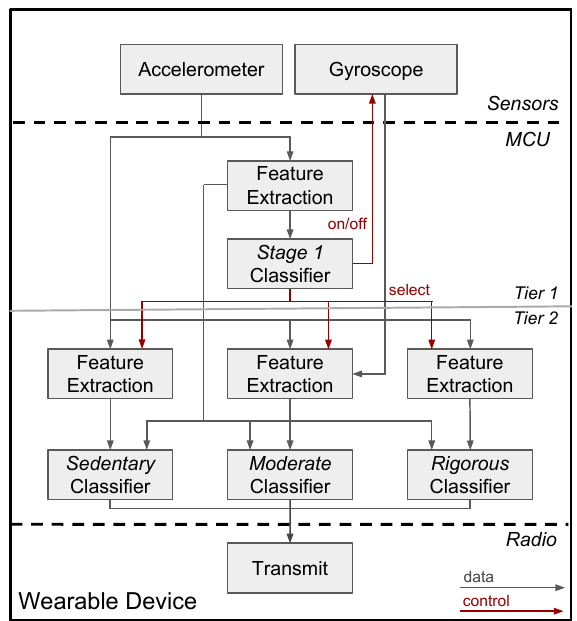
Figure 1. The proposed framework for on-board activity classification with wearable sensing systems. The framework is composed of an series of Random Forest classifiers that are structured hierarchically in two tiers. In the top tier (Tier 1), the Stage 1 classifier identifies the activity group (Sedentary, Moderate and Rigorous activity groups) and selects the corresponding Tier 2 classifier, which performs the activity classification. Only one of the Tier 2 classifiers and its corresponding feature extraction block is activated at a time depending on the output of the Stage 1 classifier. This approach allows us to keep the energy-hungry gyroscope powered-off, and activate it only when the user engages in activities whose classification can benefit from it. It is also noted that every feature extraction block extracts the features that are most informative for the respective classification